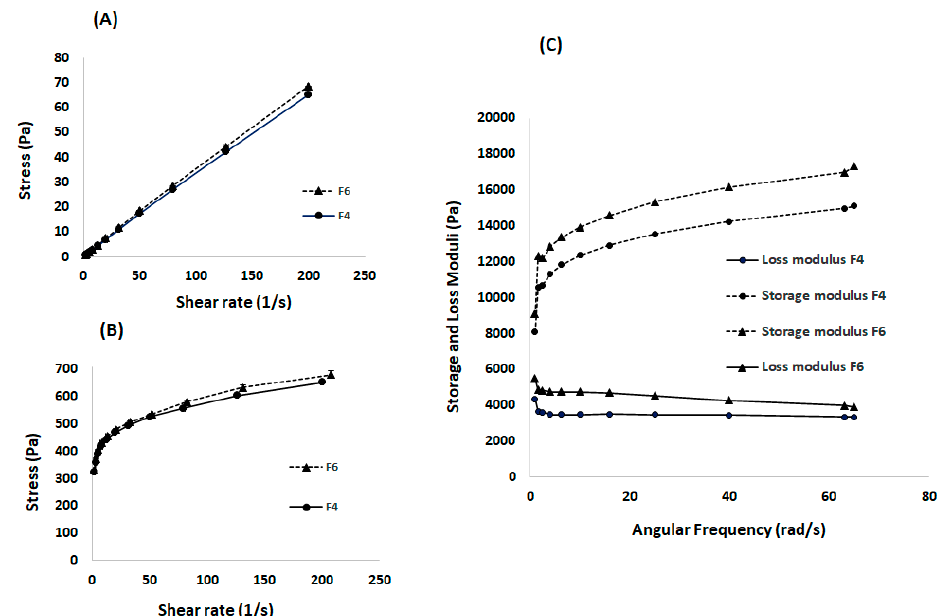
Figure 5. Rheological properties, showing ( A ) Flowability at 20 ◦ C indicating a Newtonian flow behaviour, ( B ) Flowability at 37 ◦ C indicating a pseudoplastic flow behaviour for both formulations: blank (F4) and nicotine loaded (F6), and ( C )Viscoelasticity measurements at 37 ◦ C demonstrating an elasticity with loss modulus having dominancy over the storage modulus for both for- mulations.